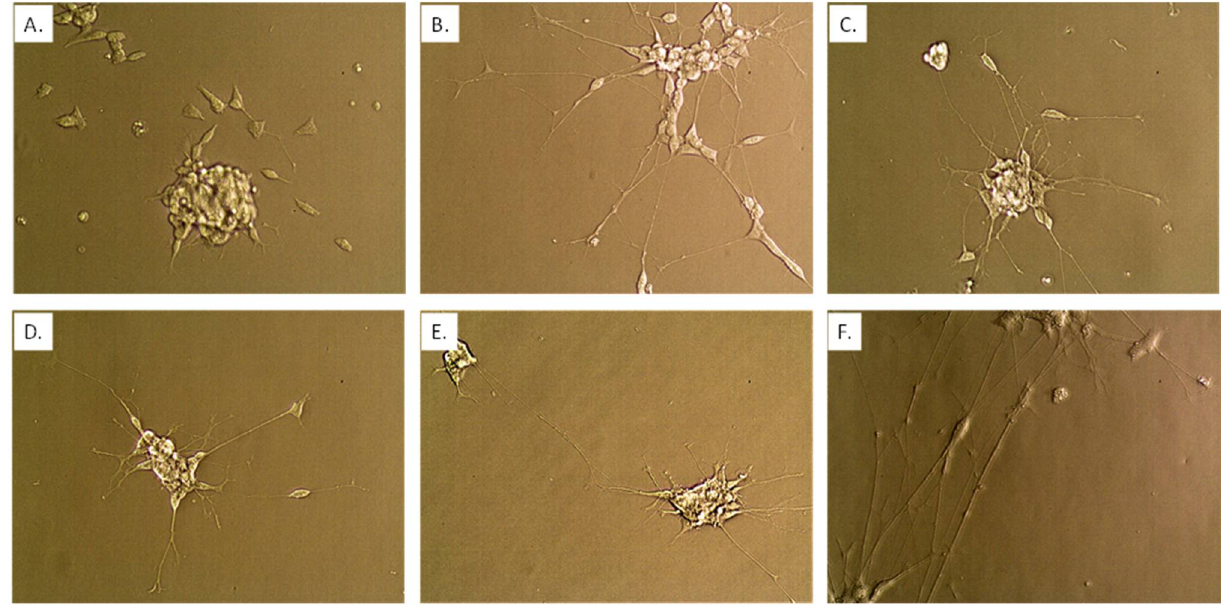
Figure 8. Neuronal state using co-culture model begun by plating n=25,000 Caco2Bbe1 cells on inserts in each well of a 24-well plate. Such were regularly refed to attain high TEER as described in Figure S2. Eleven days after starting to grow the inserts, a separate 24-well plate was given SH-SY5Y cells ( n = 400) in complete (10% FBS) media. On day 14 after plating the inserts, the apical media was switched to deplete media with 1% FBS (basal media remained at 10% FBS). On the same day, media in the SH-SY5Y wells was replaced with fresh media lacking FBS (0%) containing 10 µM retinoic acid (RA). Some controls remained in complete media. Both plates were returned to the incubator for 2 more days. At this time, the untreated panel ( A ) and 2-day RA-treated panel ( B ) neuroblastoma cells were photographed at 40× magnification. A second batch of serum-deplete media + RA was applied to some of the experimental SH-SY5Y cells (becoming 0.5 mL volume) and inserts were transplanted atop them; although there were 2 more variations (no second dose of RA but adding inserts, or a second dose of RA but remaining in open wells). After two more days in the incubator, the inserts were briefly lifted so that neurons could be photographed without staining at 40× mag- nification. Panel ( C ) represents the effects of a single dose of RA then two more days under inserts. After two more days, the inserts were again briefly lifted so neurons could again be photographed panel ( D ). After two more days, the inserts were again briefly lifted so neurons could again be pho- tographed panel ( E ). The image in panel ( F ) comes after two scheduled doses of RA without inserts placed atop them and then incubated the same time course as panel ( E ). The set-up recommended for treatment studies is probiotics begun with panel ( C ) (state of neurons when probiotics were administered) and ending with panel ( D ) (control neuron state compared to the end of studies).